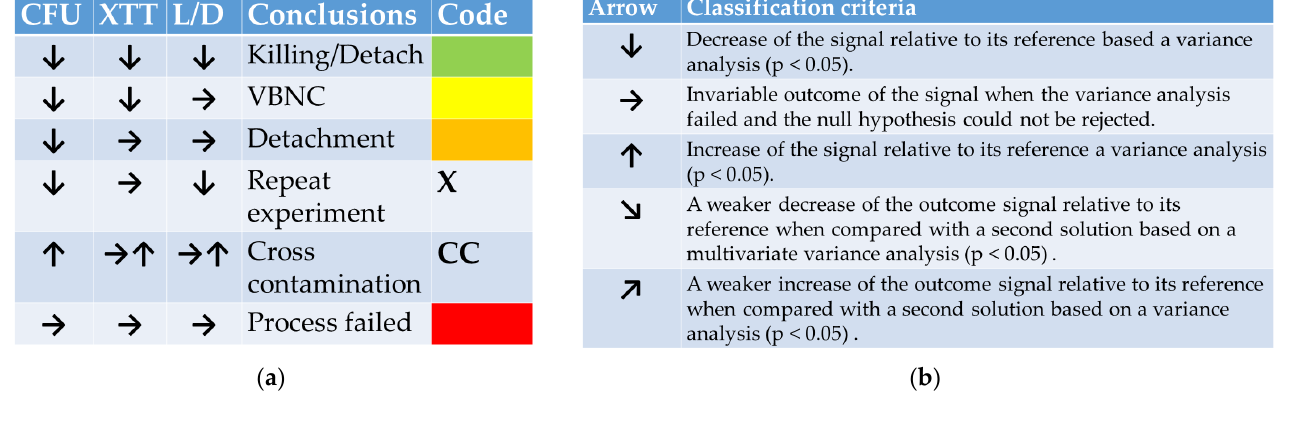
Figure 1. ( a ) Interpretation scheme for Figures 3 and 4 listed in a tabular form. Relative to its reference, a down-pointing arrow shows a decreased assay outcome, a horizontal arrow mirrors, and an up-pointing arrow stands for an increased test outcome. ( b ) Decision scheme for the classification criteria of a PTW treatment impact on cell viability.